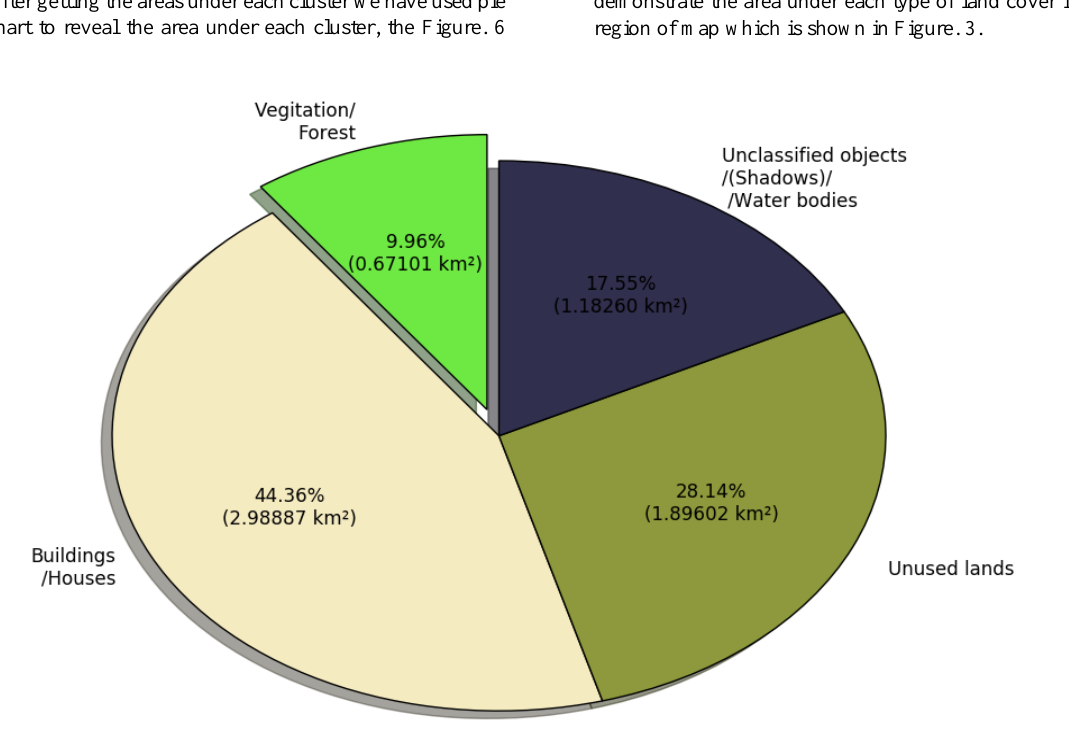
Figure. 6 The area under different types of land